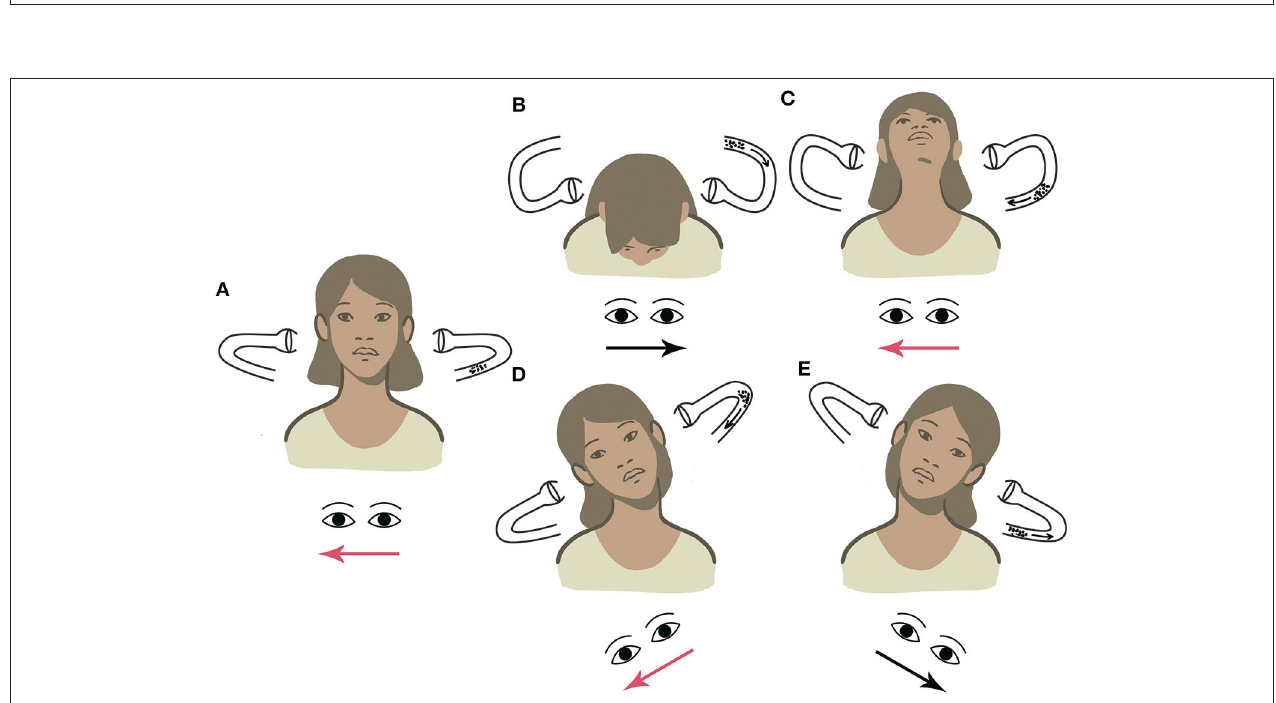
FIGURE 5 | UBP for left geotropic LSC-BPPV. (A) PSN: right beating. (B) HPT with forward head bending: left-beating nystagmus. (C) HPT with backward head bending: right-beating nystagmus. (D) UHRT with rightward head tilt: right-beating geotropic nystagmus. (E) UHRT with leftward head tilt: left-beating geotropic